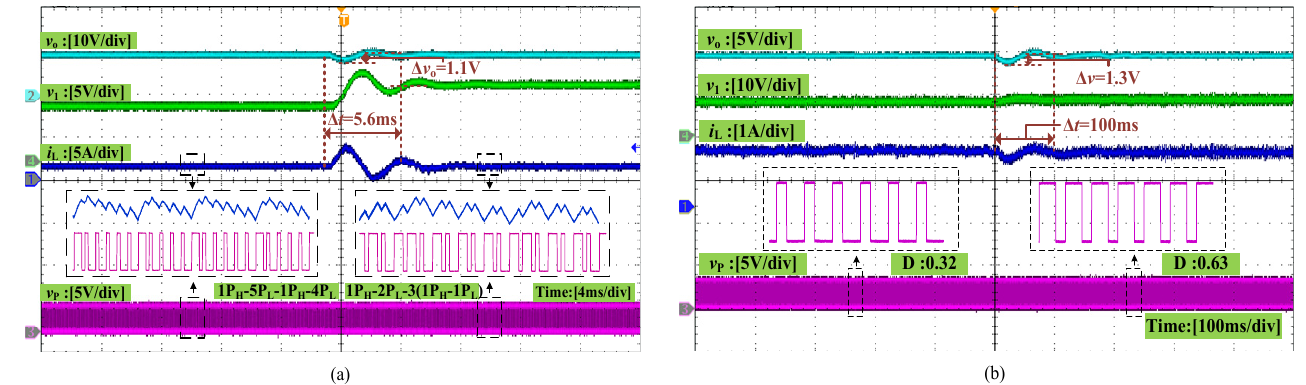
Figure 14. Experimental waveform with the load change with ( a ) the proposed CC&OV-PT control and ( b ) the conventional PWM control.